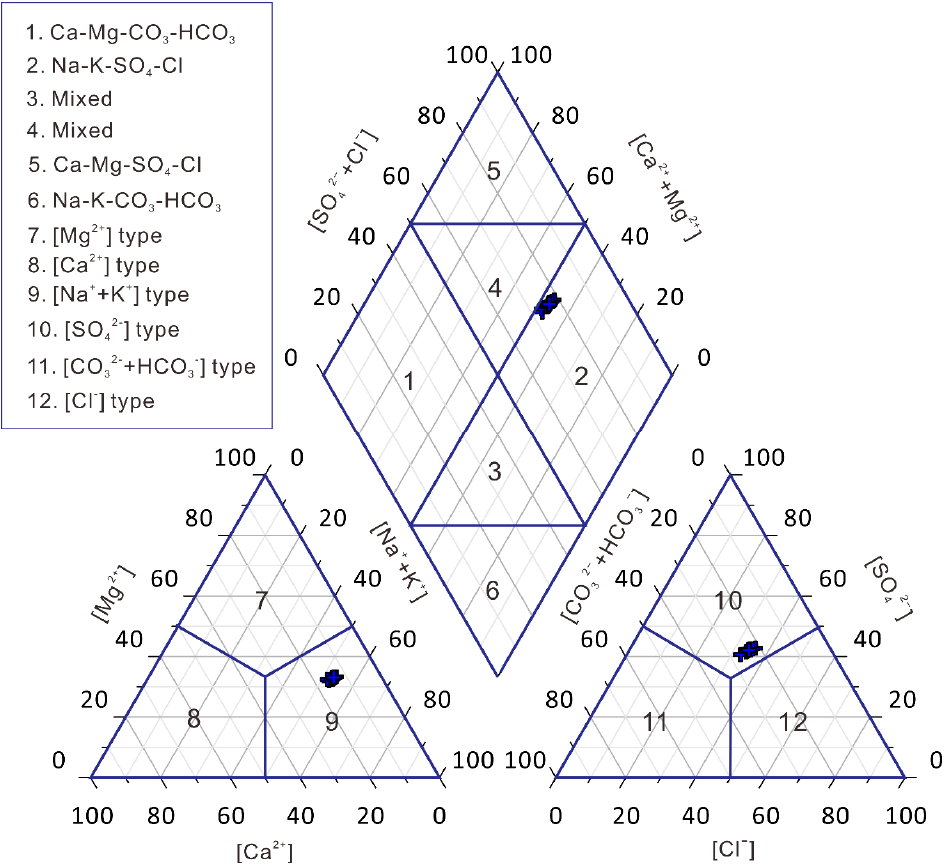
Figure 4. Piper diagram of the waters from Bosten Lake. Water 2020 , 12 , x FOR PEER REVIEW